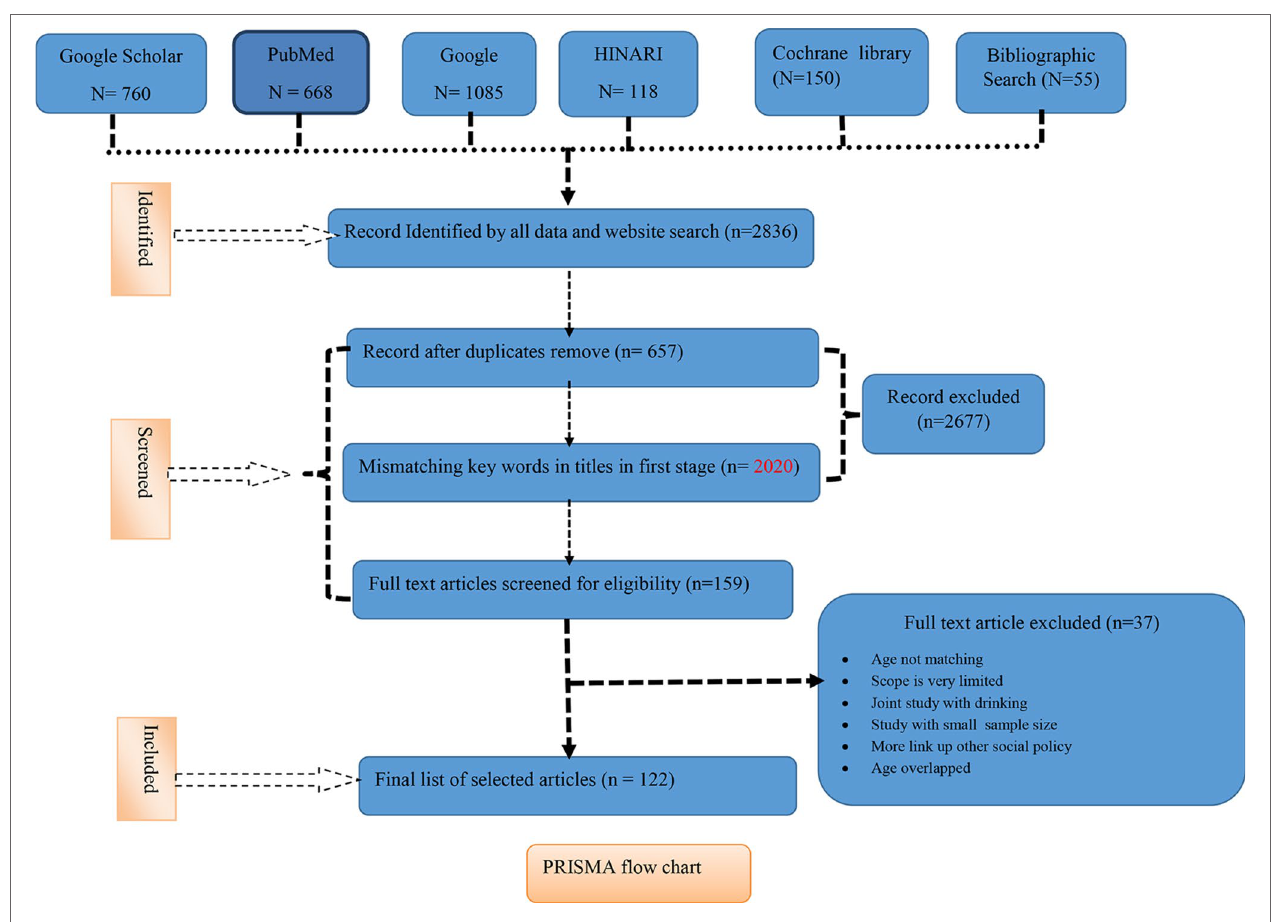
FIGURE 1 | PRISMA flow chart of research